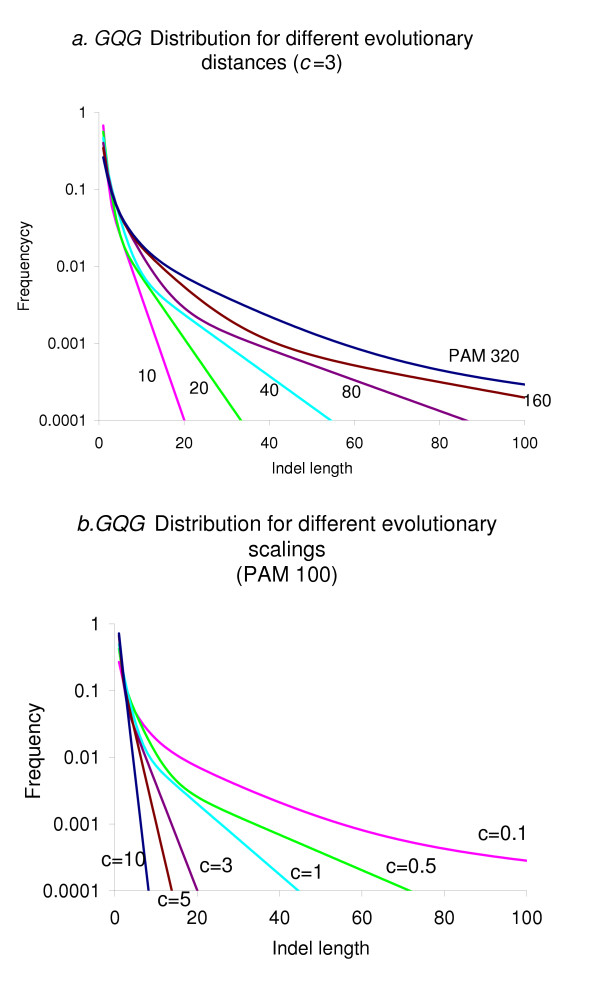
The GCG distribution of indel length is determined by the evolutionary distance for a given evolutionary scale factor c. The expected frequency of indels of given lengths are plotted. In a. the distribution is shown for different evolutionary distances (as labelled next to the corresponding lines). In b. the evolutionary distance is fixed and the GCG length distribution is plotted for different evolutionary scale factor values (as labelled next to the corresponding lines).